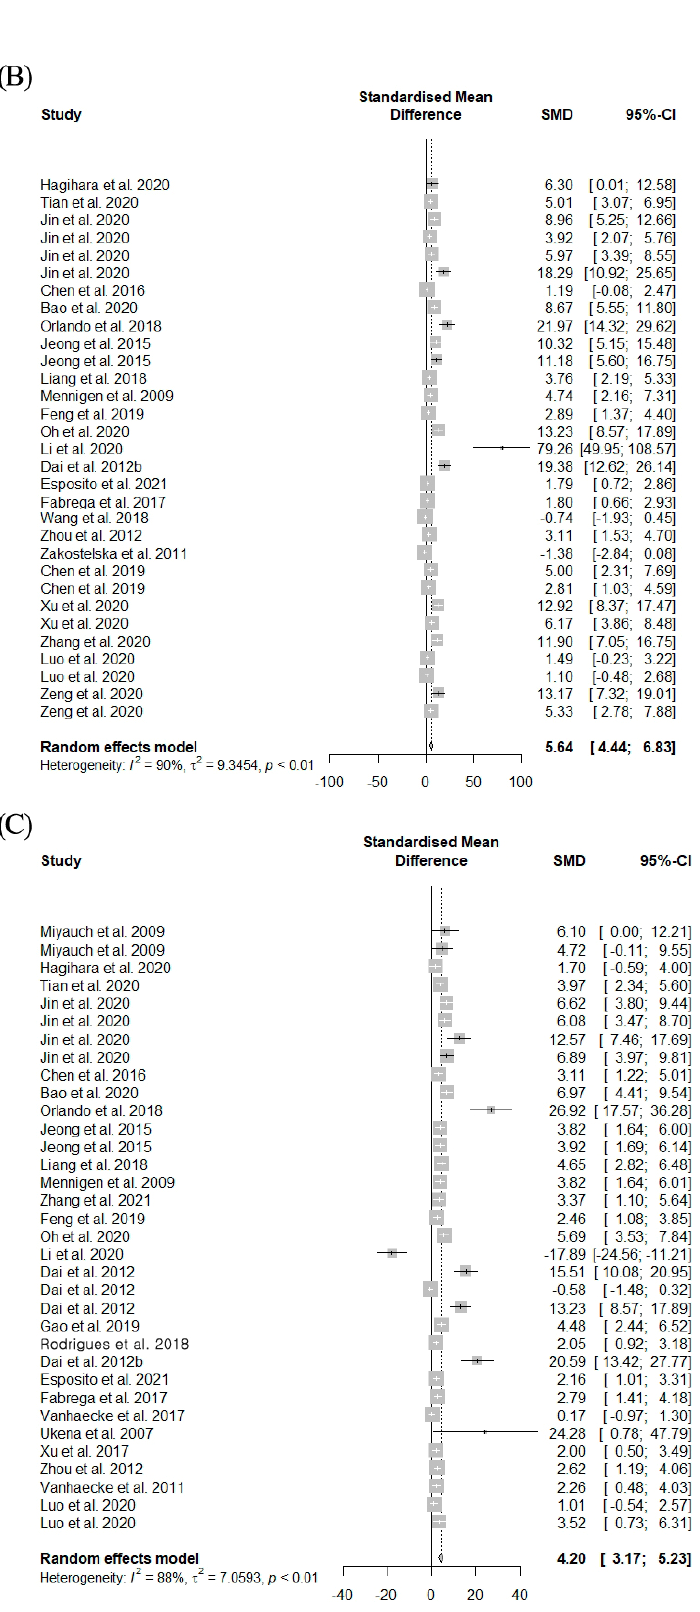
p < 0.01; I 2 = 90%). It means that probiotics administration is effective for mRNA expression of TJP in an animal model. In the case of claudin (Figure 3A), some studies, such as Seo et al. [35] and Yeo et al. [55], showed a negative effect size. However, except for two studies, all other studies showed a positive effect size. Figure 3B shows the mRNA expression of occludin. Most studies indicated a positive effect size except for Biagiolo et al. [48] and Rodriguez ‐ Nogales et al. [49]. In particular, Sheng et al. [33] denoted the largest effect size (SMD: 29.45; 95% CI: 15.03–43.86). Similarly, most studies showed a positive effect size in Figure 3C except for Yeo et al. [55]. Tulyeu et al. [54] showed the largest SMD (SMD: 20.43; 95% CI: 11.44–29.41). However, its weight in the random effect model was 0.6%. On the other hand, the study of Xin et al. [29] showed the highest weight (3.5%) in the random effect model. Among the analyzed items, occludin showed the highest Q statistics (499.12) with significance ( p < 0.0001) in the random effect model of TJP mRNA expression.